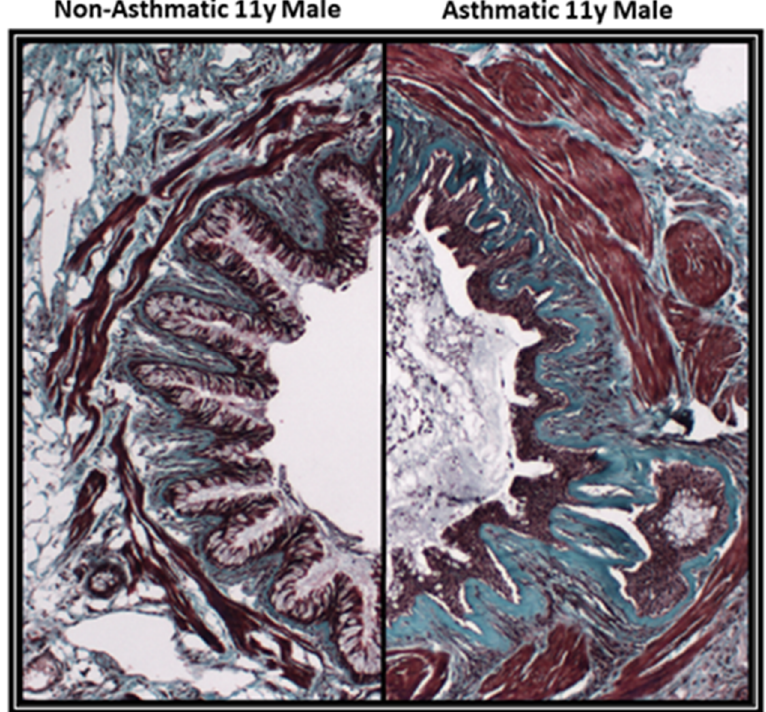
Figure 1. Features of airway remodeling in the large airways in asthma. Airway sections from formalin-fixed paraffin-embedded (FFPE) tissue stained with Masson’s trichrome stain for collagen (blue-green), cytoplasm and intercellular space (light purple) and keratin and muscle (red). The left image in the panel: a large airway from a normal control individual with no respiratory disease. The right image in the panel: an age- and sex-matched large airway of an asthmatic individual showing airway remodeling including (i) increased smooth muscle mass; (ii) damaged airway epithelium; (iii) basement membrane thickening (iv) mucus plugging of the airway lumen and (v) subepithelial fibrosis.